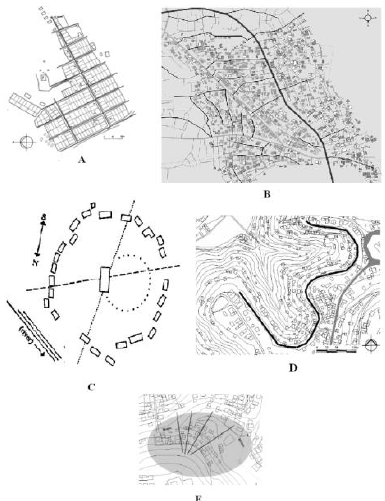
Figure 4. Examples of Major Emergent Settlement’s